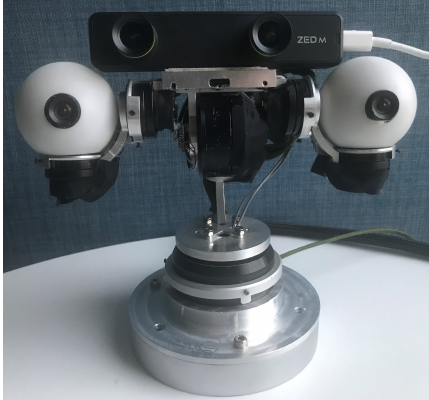
Figure 2. The anthropomorphic robotic bionic eyes.